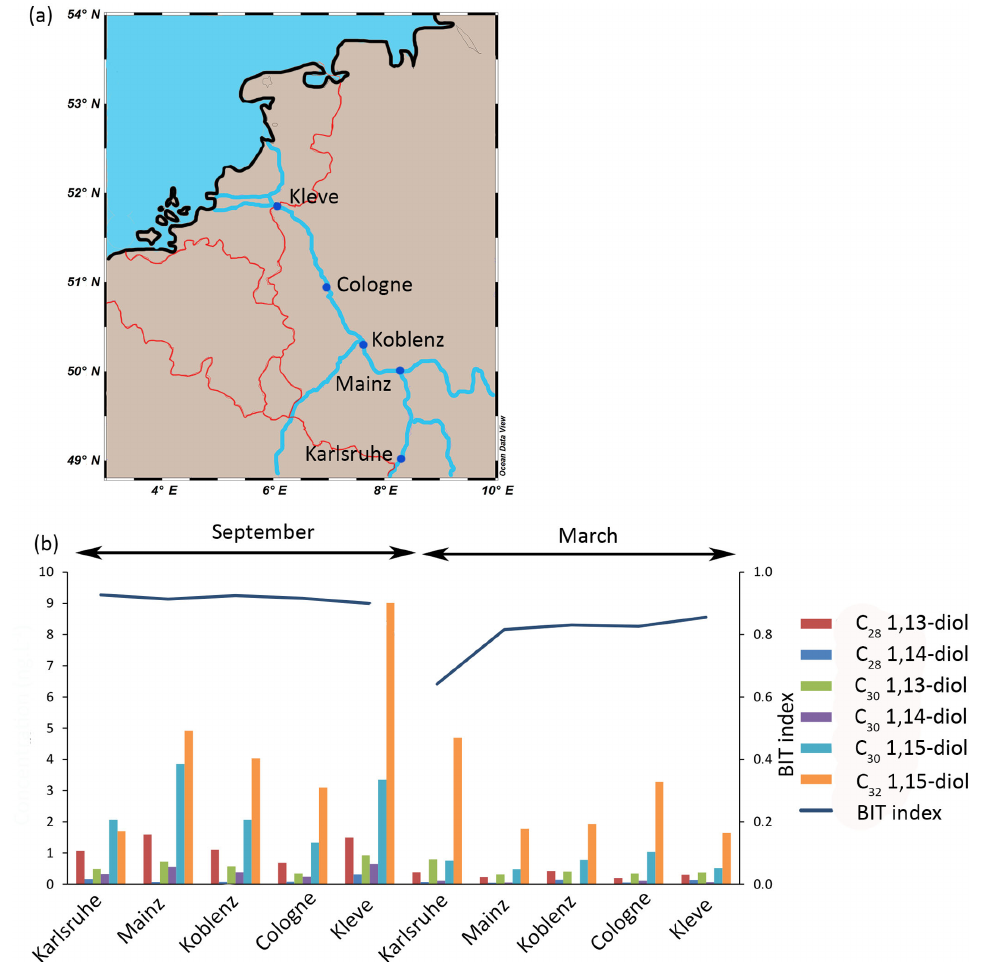
Figure 3. (a) Location of the Rhine samples ( n = 1 per site) and (b) concentration of LCDs and BIT values (September and March) in the Rhine